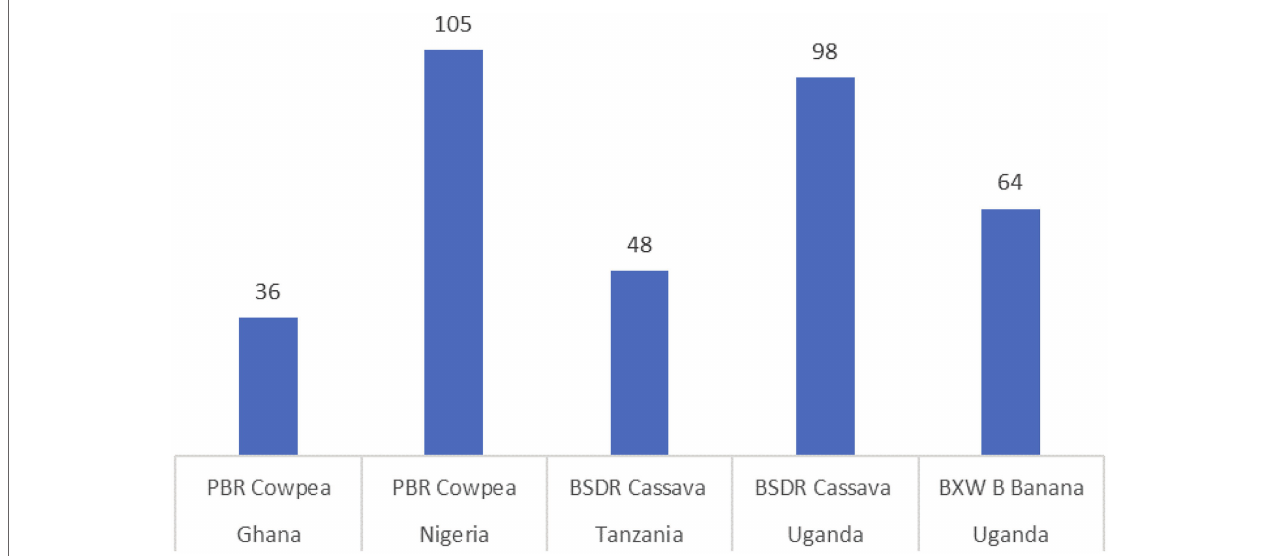
FIGURE 3 | Internal rate of return (IRR)* to R&D investments incurred in-country by crop/trait (percentages; Dzanku et al., 2018; Phillip et al., 2019; Kikulwe et al., 2020; Ruhinduka et al., 2020). *IRR estimates include only R&D costs incurred in country.